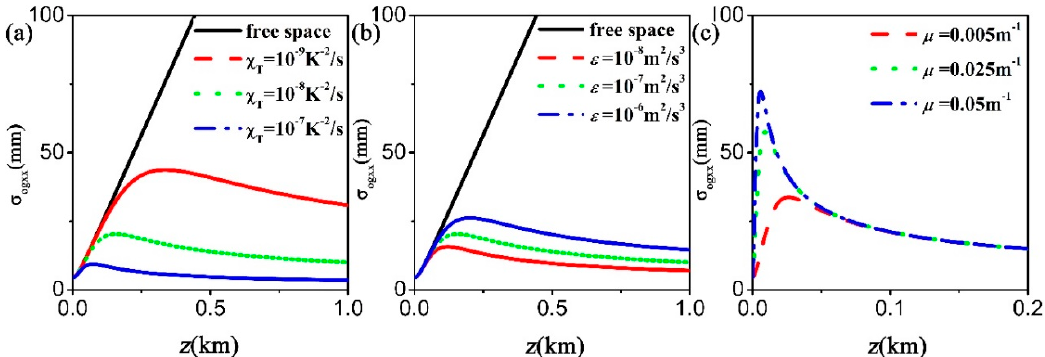
σ of a TAGSM beam via the propagation χ ; ( b ) for different values T